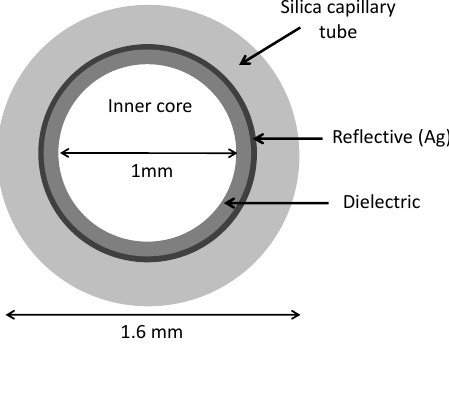
Figure 1. Cross-section of the cylindrical hollow waveguides. The inner part consists of a metallic Ag layer coated by a single dielectric film of AgI or polystyrene (Ps) or by AgI/Ps double dielectric film. The outer part consists of silica with UV acrylate external